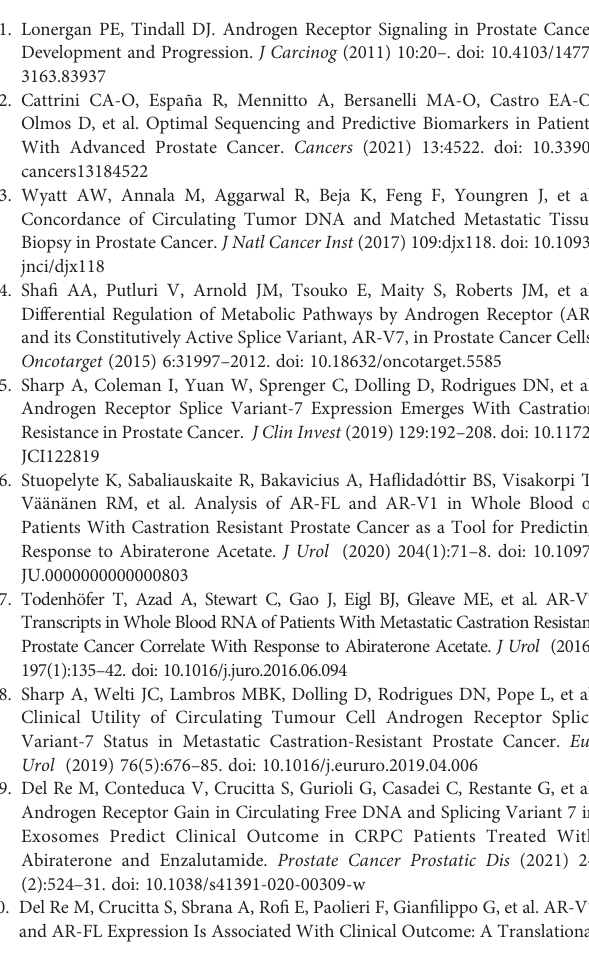
Supplementary Figure 2 | Forest plot of hazard ratios (HRs) for association of liquid biopsy AR-V7 status with OS (A) , PFS (B) , PSA-PFS (C) in all studies. Subgroup analysis were performed based on AR-V7 detection technique type. Pooled HRs were calculated using random effect model. AR-V7: androgen receptor splice variant 7. CI: con fi dence interval and bars indicate 95% CIs. PCR, polymerase chain reaction; qRT-PCR, quantitative real time PCR; ddPCR,